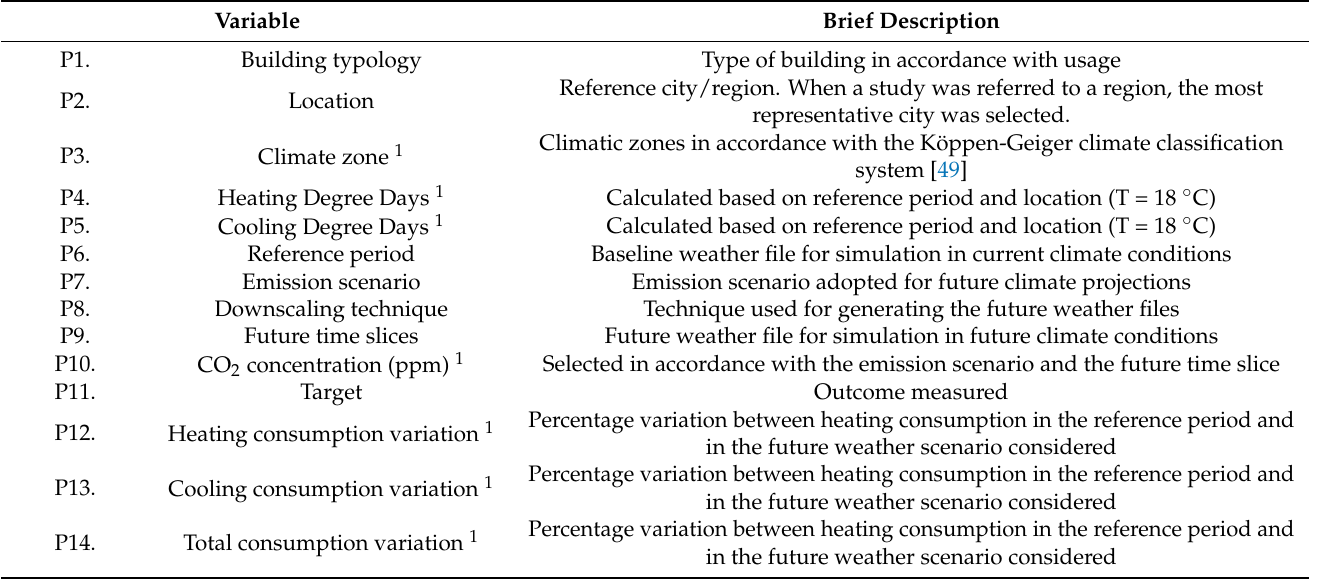
Figure 1. PRISMA flow diagram, adapted from [44]. Table 3. List of extrapolated